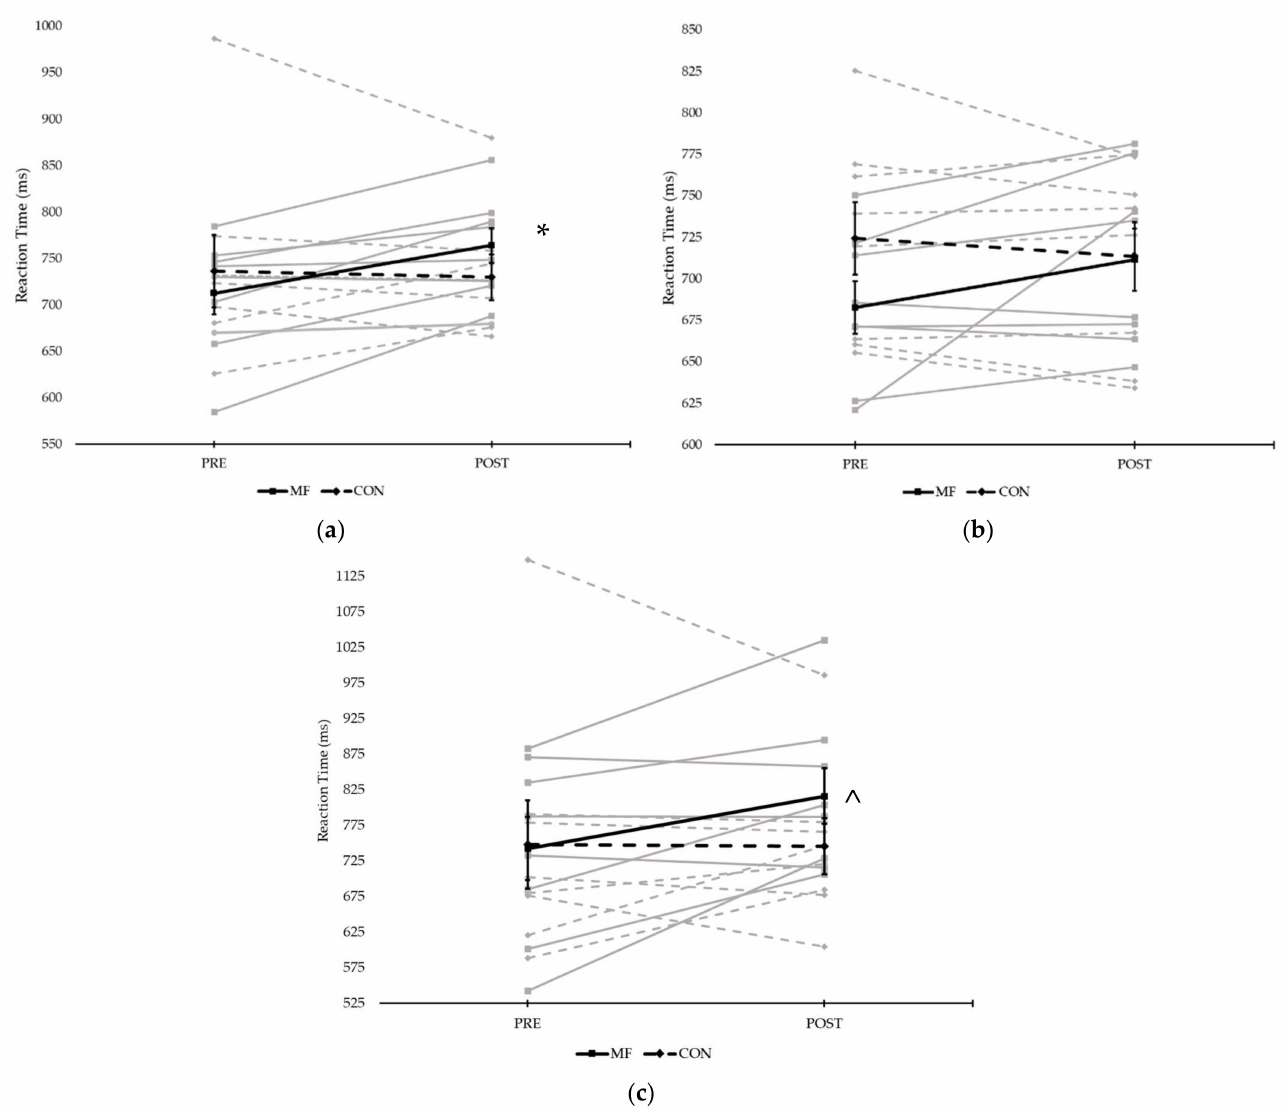
Figure 3. Reaction time on the visuomotor task comparing both conditions pre- and post-experimental/control task in all individuals: ( a ) all stimuli types; ( b ) simple stimuli (red, green and yellow); and ( c ) complex stimuli (blue) (* = significant difference between pre and post in the MF condition; ˆ = significant difference between conditions post task; grey lines represent individual responses, bold lines represent means ±